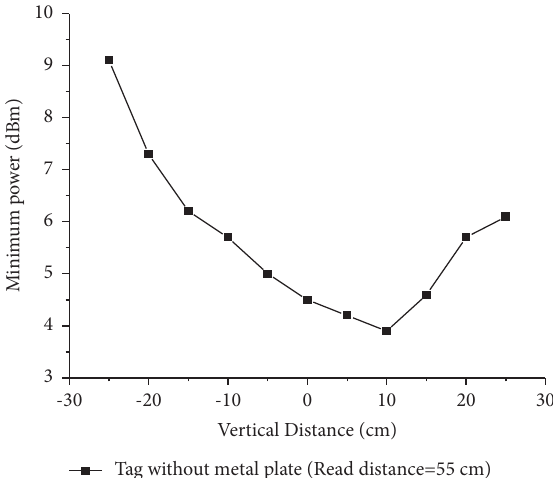
Figure 10: Minimum power vs. vertical distance when the tag antenna is placed in the free